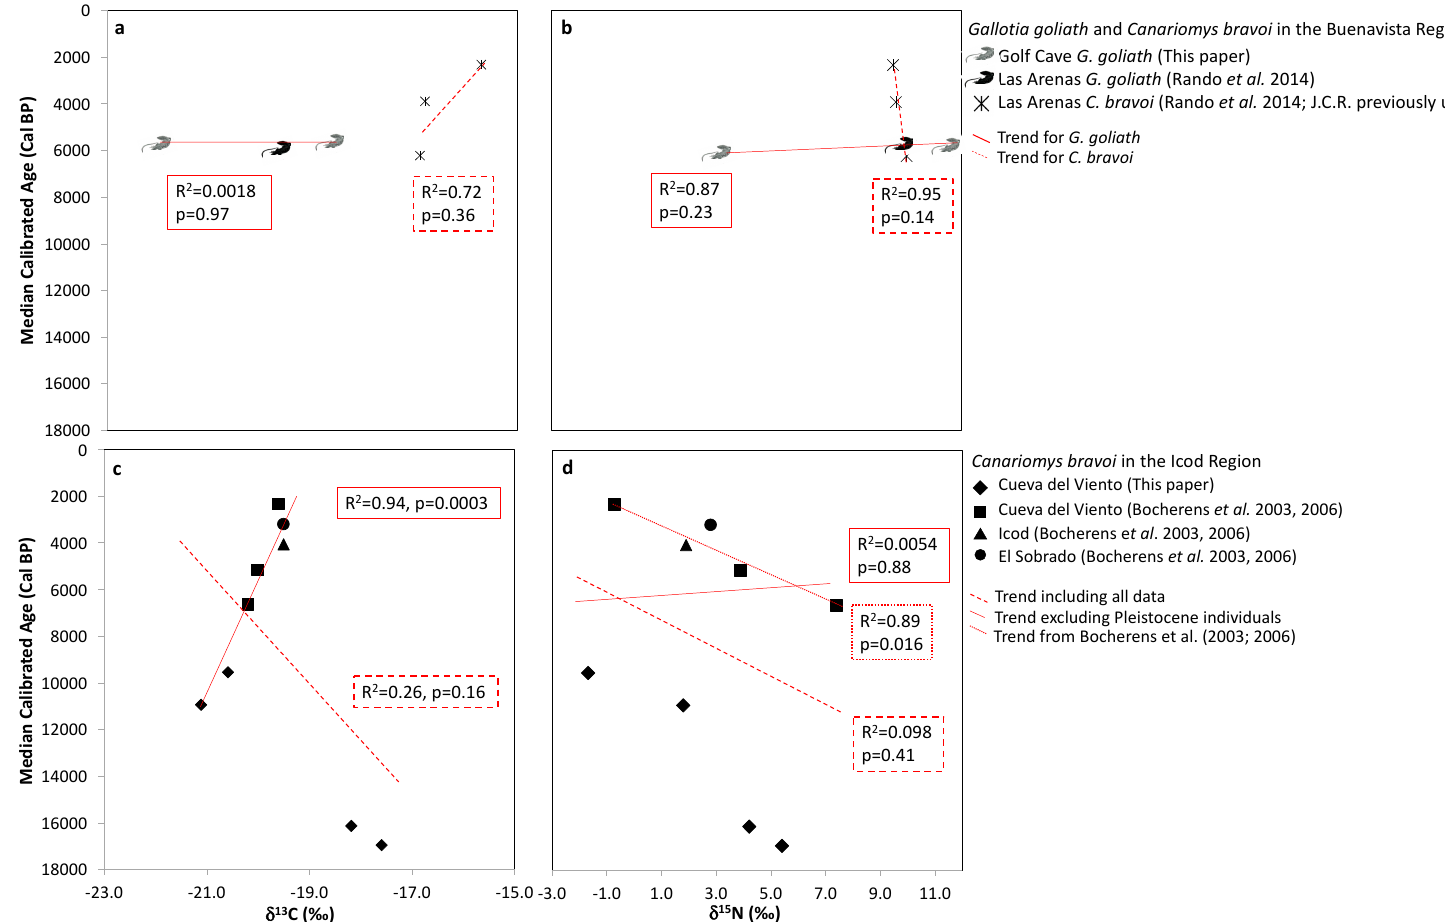
Figure 6. Temporal isotopic trends for ( a and b ) Canariomys bravoi and Gallotia goliath from the Buenavista del Norte region, and ( c and d ) C. bravoi in the Icod region. For Icod (panels c and d), we include trendlines that both include and exclude the two individuals that date to the Pleistocene. We also show the relationship between δ 15 N and calibrated age using just the data published by Bocherens et al. [18,44].